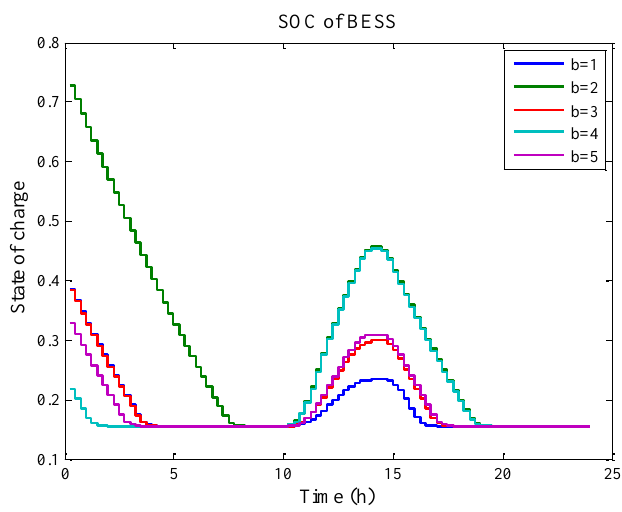
Figure 27. SOC time series (Case study 3).